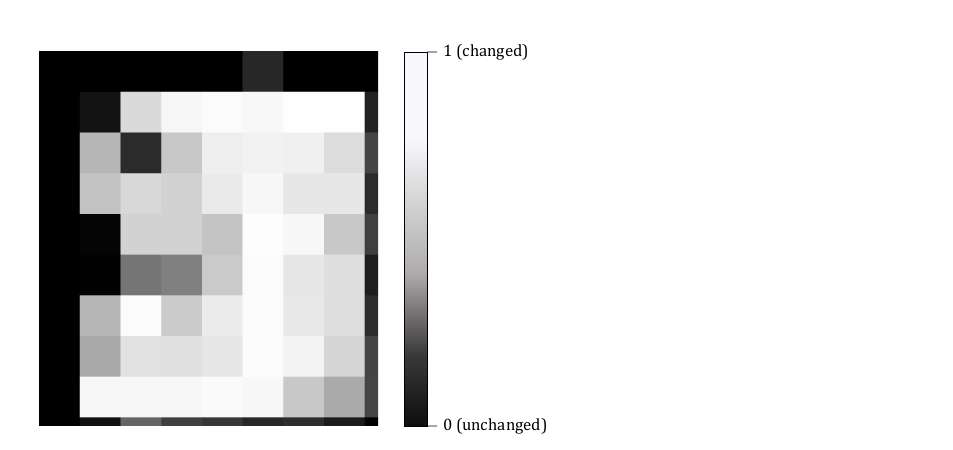
Figure 8. Coarse change map of the Beirut city obtained by the classification model EF-CNN. The darker the section of the map, the lower the probability of having a considerable amount of changes in the area.